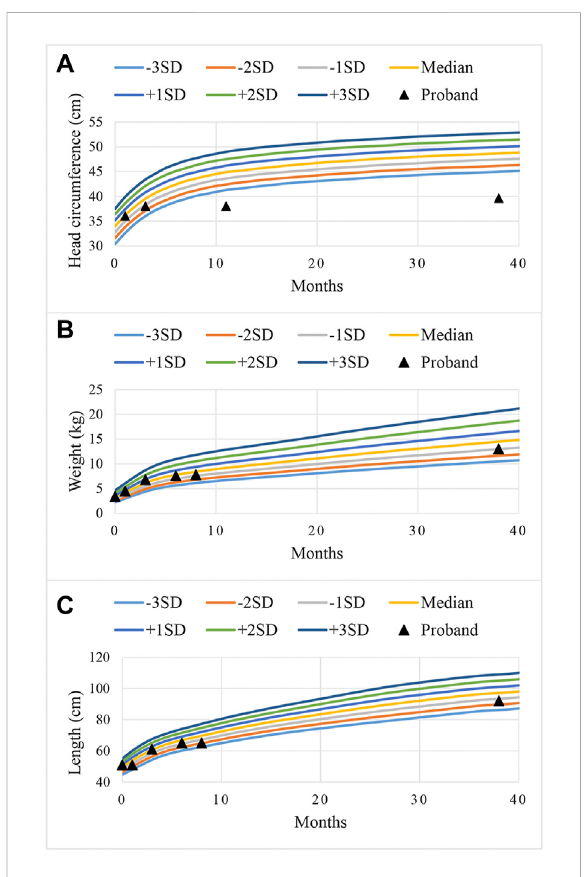
FIGURE 1 Curves of standard deviations (SD) during the growth of head circumference (A) , weight (B) , and length (C) for the proband. The color curves were the referenced growth curves for Chinese